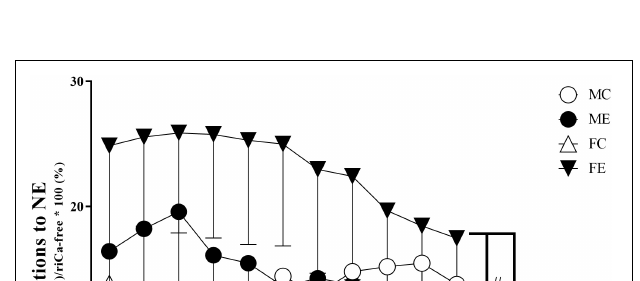
FIGURE 7 | Testosterone contraction of the segments in 10 − 8 and 10 − 6 M at 50 mmHg from the MC, ME, FC, and FE animals. The testosterone contraction was significantly lower in the females than in the males in the control groups. As a result of the exercise, the testosterone contraction decreased in the male groups. The data are expressed as the mean (SEM) values. The significance levels of the two-way ANOVA and Tukey’s post hoc tests between the four groups are shown. ∗ P < 0.05 MC vs. ME and § P < 0.05 MC vs.